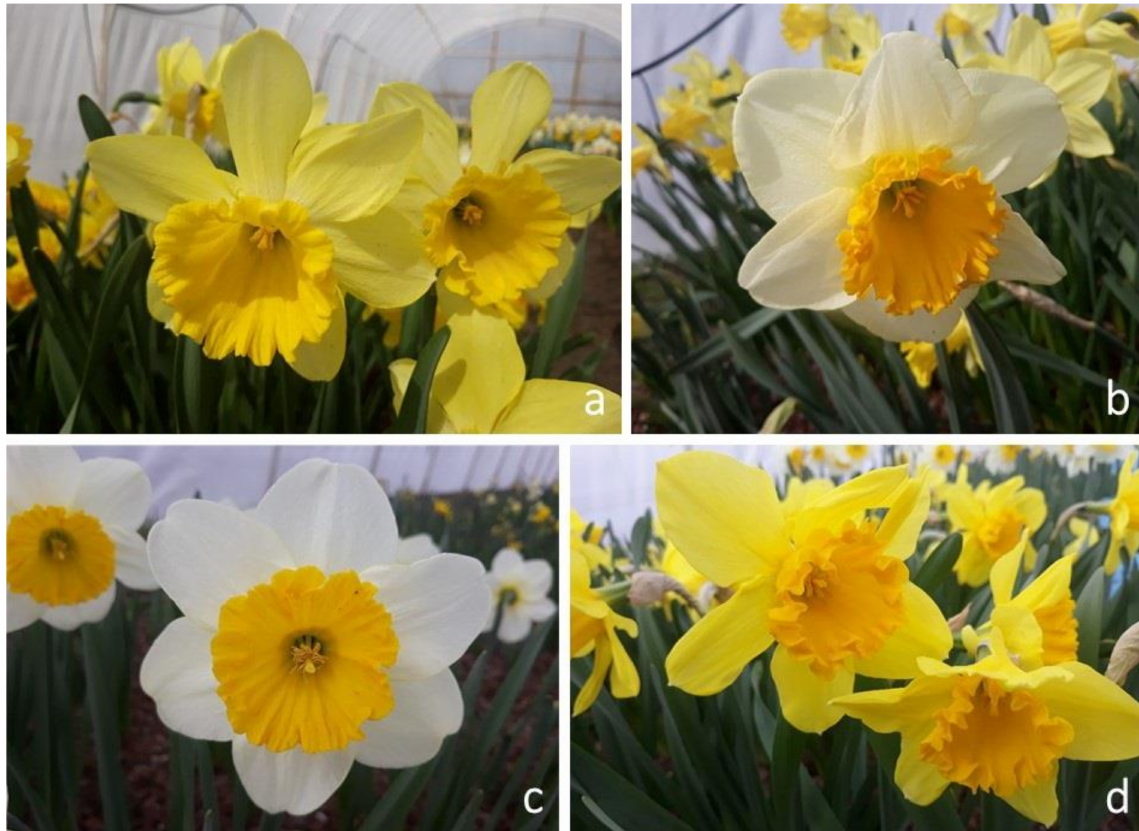
Figure 5. Breeding clones of Narcissus (daffodils) crossed at the Research Institute of Horticulture in Skierniewice, Poland, currently propagated in vitro to obtain more bulbs for further evaluation: ( a ) 8–97; ( b ) 7–97; ( c ) 34–97; ( d )